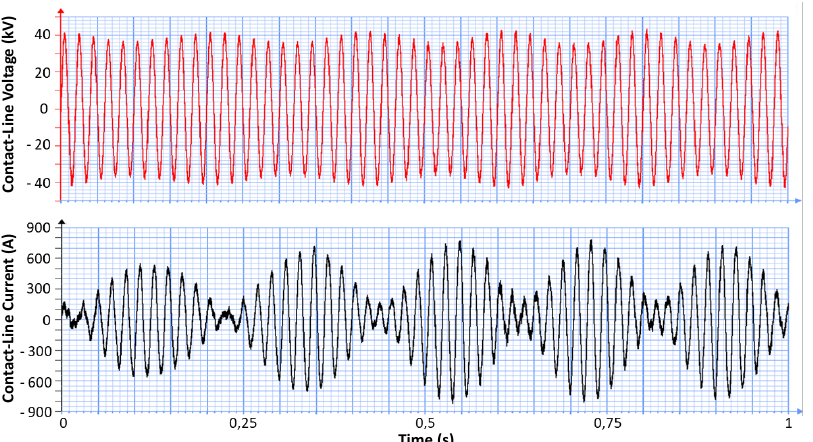
Figure 1. Contact-line voltage and current supplied by the substation. AC 25 kV/50 Hz electric power supply. Measured in Thionville, France. Reprinted with permission from Ref. [5]. Copyright 2014